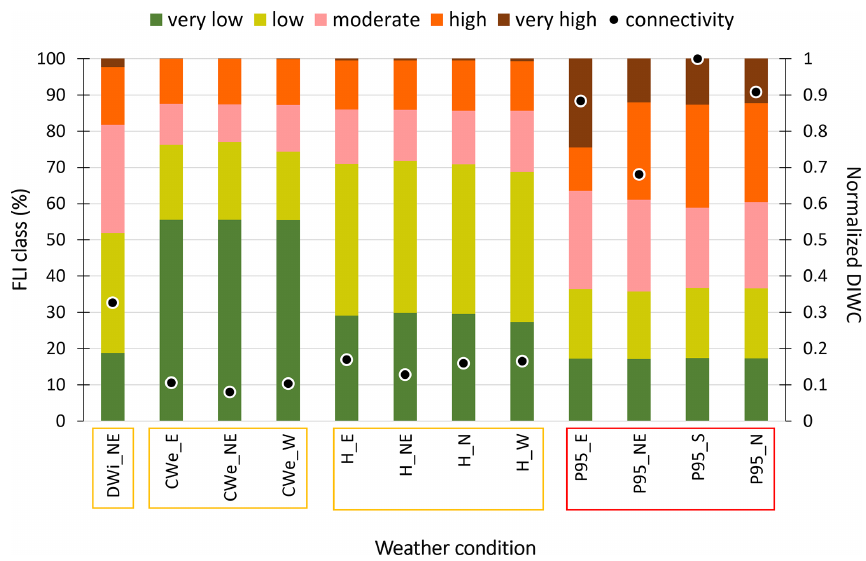
Figure 8. Percentage of fire intensity (FLI) classes and normalized wildfire connectivity index (DIWC) for each weather condition. Simulated FLI was classified in five classes (Appendix D). Yellow boxes represent the weather types from the historical weather condition, while the red box represents the extreme weather condition. Acronyms refer to the weather types and the corresponding wind directions with a frequency higher than